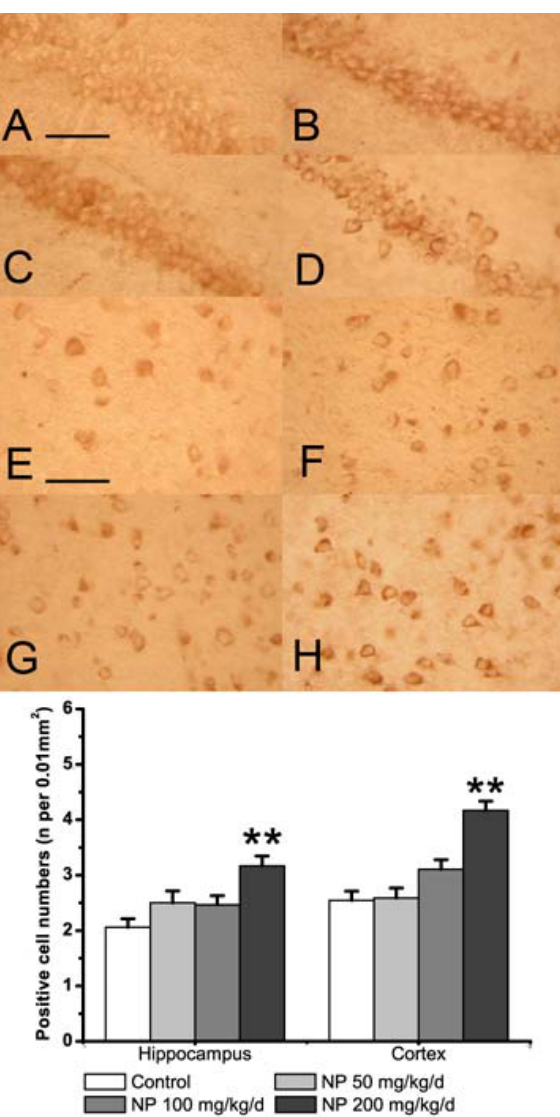
Figure 3. The effect of NP on the expression of iNOS as determined by immunohistochemistry in the hippocampus (A-D) and cortex (E-H). (A, E) Vehicle control. (B, F) NP 50 mg/mL per day group. (C, G) NP 100 mg/mL per day group. (D, F) NP 200 mg/mL per day group. Scale bars (A–H): 100 µm. The bands below show the number of iNOS positive cells in the hippocampus and cortex. Values are expressed